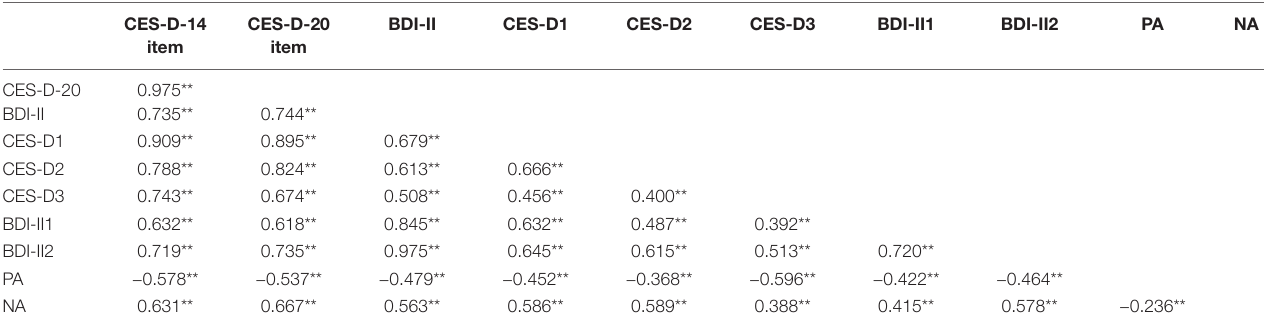
TABLE 3 | Correlations between the subscales of CES-D, BDI-II, and PANAS. CES-D-14